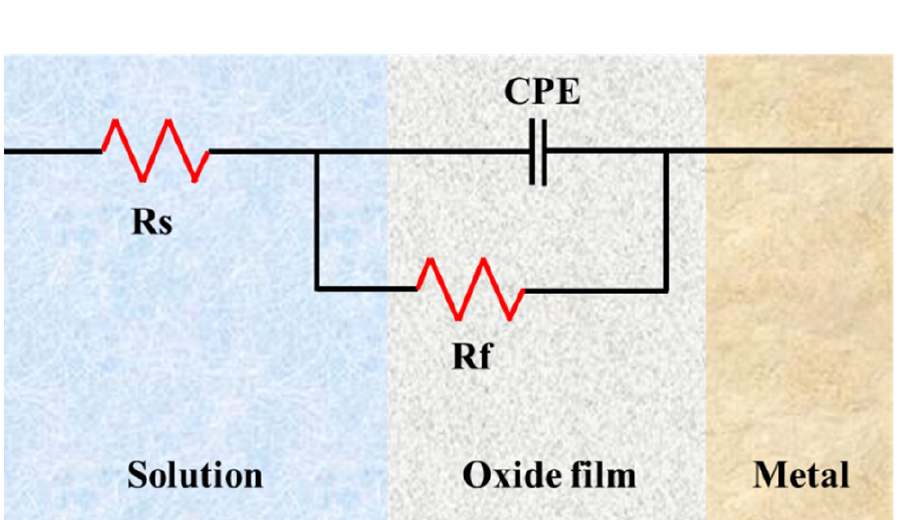
Figure 15. Impedance fitting circuit diagram.